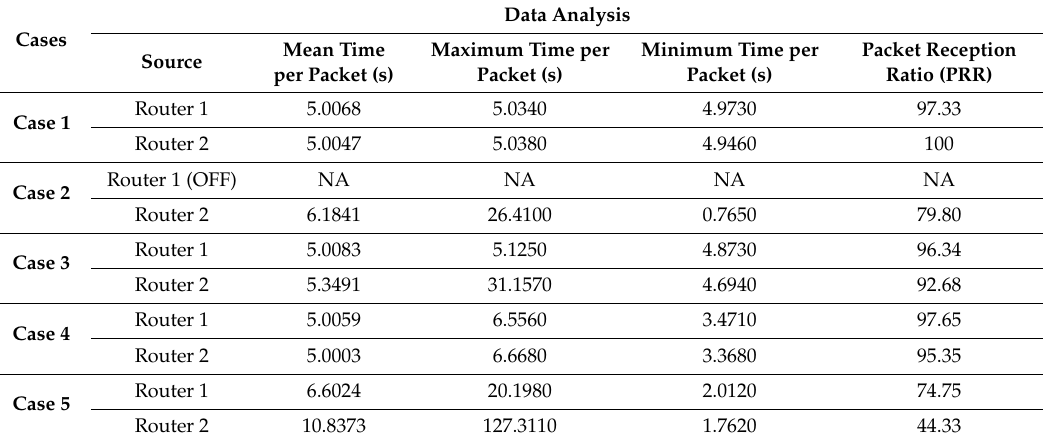
Table 1 details the results. Table 1. Results achieved in test Table 1. Results achieved in test 5.1.